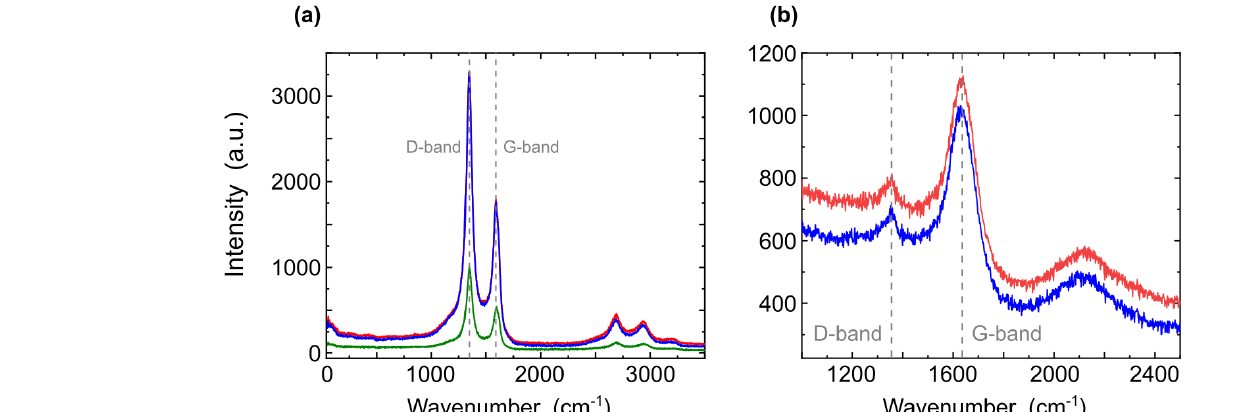
Figure 4. Raman spectra of natural shungite ( a ) before and ( b ) after sonication. To determine the numbers of sp2 and sp3 carbon bonds, we studied the samples using X-ray photoelectron spectrometry. Data are presented in Table 2 and in Figure 5.